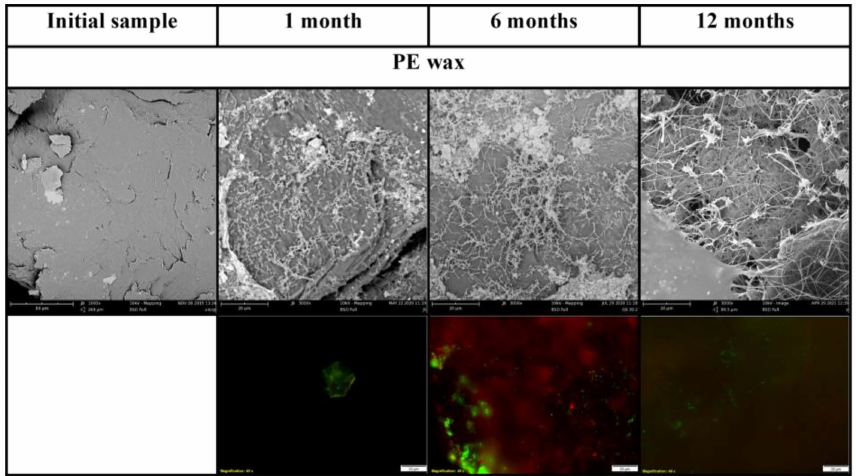
Figure 2. Scanning electron micrographs and live/dead photos of PE sample. Magnification of initial SEM samples 1000 × , incubated SEM samples 3000 × , fluorescent microscopy samples 400 ×